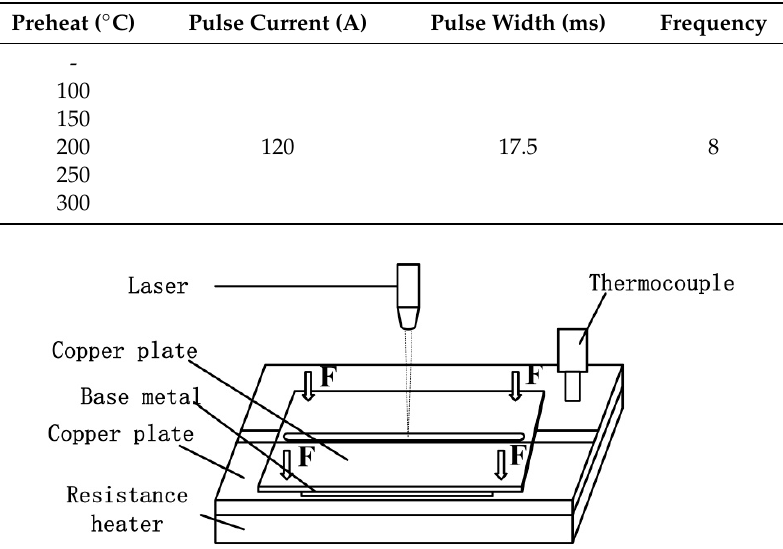
Figure 1. The schematic diagram of the welding device.